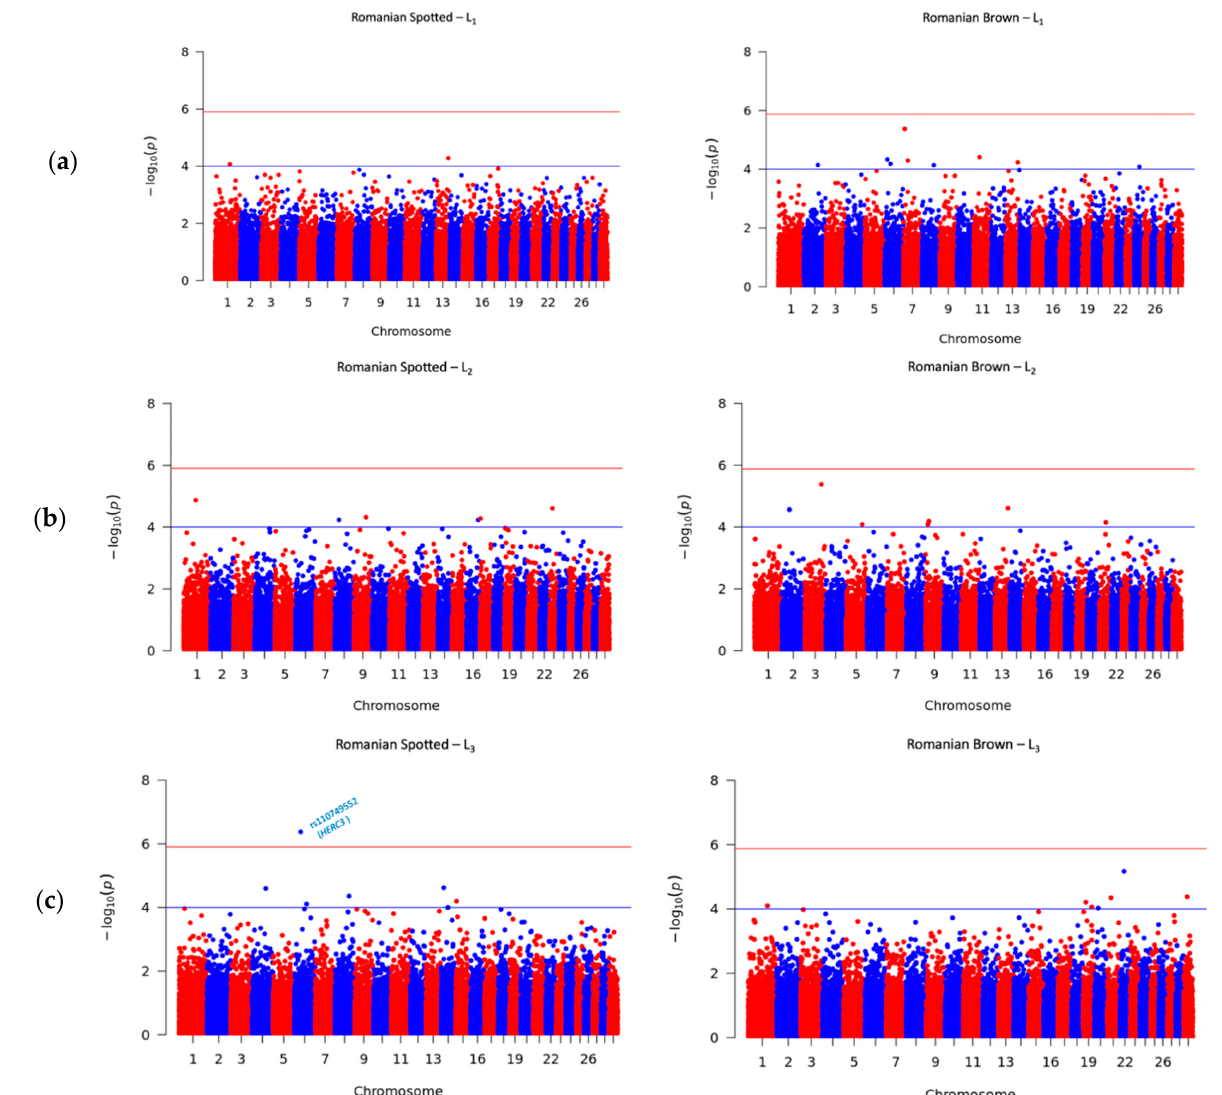
Figure 2. Manhattan plots for somatic cell score (SCS) in the Romanian Spotted ( left ) and Romanian Brown breed ( right ). The blue line indicates the suggestive p value threshold of − log 10 ( p ) ≥ 4.00. The red line indicates the Bonferroni genome- wide significance p value threshold at − log 10 ( p ) ≥ 5.89. The y -axis shows the − log 10 ( p ) of 40,305 SNPs, and the x -axis shows the chromosomal positions. ( a ) First lactation; ( b ) Second lactation; ( c ) Third lactation. Table 2. List of single nucleotide polymorphisms (SNPs) in the Bos taurus autosomes showing significant ( − log 10 ( p ) ≥ 4.00) associations with SCS in the Romanian Spotted breed. Parity